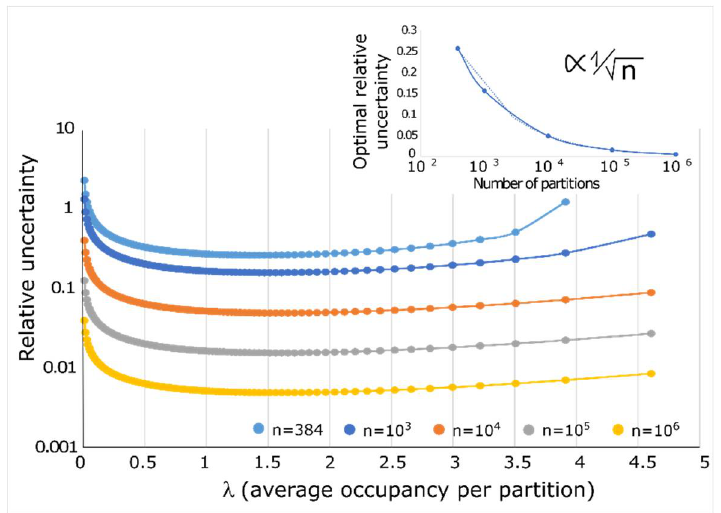
Figure 5. Quantification accuracy of dPCR. The precision of dPCR is non-uniform and depends on the average occupancy of target sequence per partition. The precision of dPCR also increases with an increasing number of partitions (distinct colors). The inset shows that the evolution of the relative uncertainty (taken at λ ≈ 1.6) decays as an invert square root of the number of